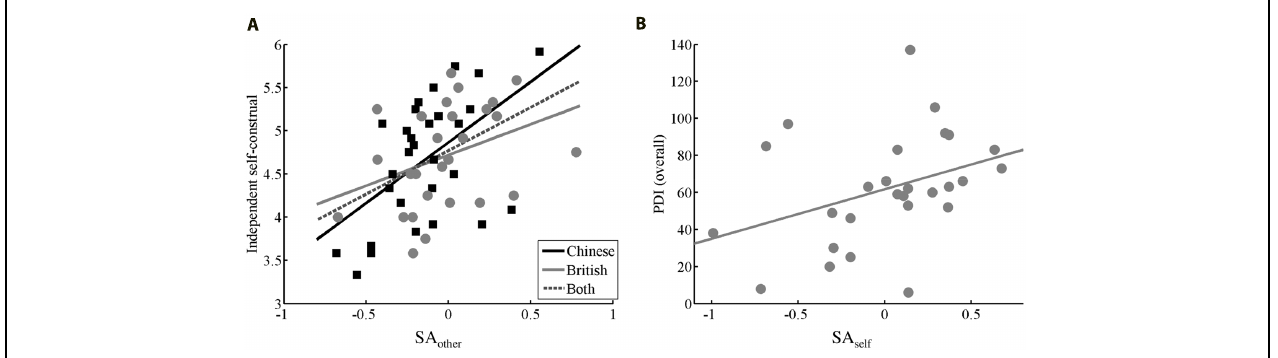
FIGURE 3 | Correlation results. Scatter plot with SA other on x-axis and Independent self-construal on y-axis (A) , and SA self on x-axis and PDI (overall) score on y-axis (B) . Linear fit was shown with lines. Low SA self /SA other values correspond to a strong sensory attenuation effect. PDI, Peters et al. (2004) delusion inventory; SA self , sensory attenuation for self-generated stimuli; SA other , sensory attenuation for others generated